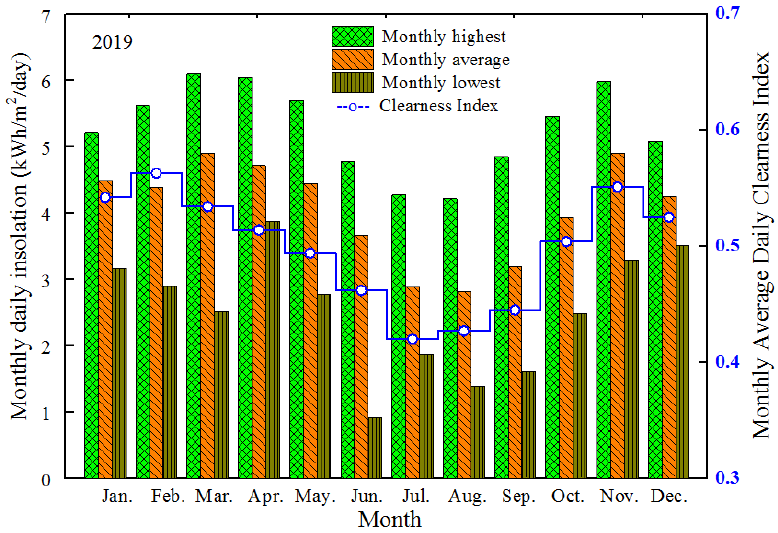
Figure 5. Measured monthly in-plane solar irradiation with clearness index from Homer SW.